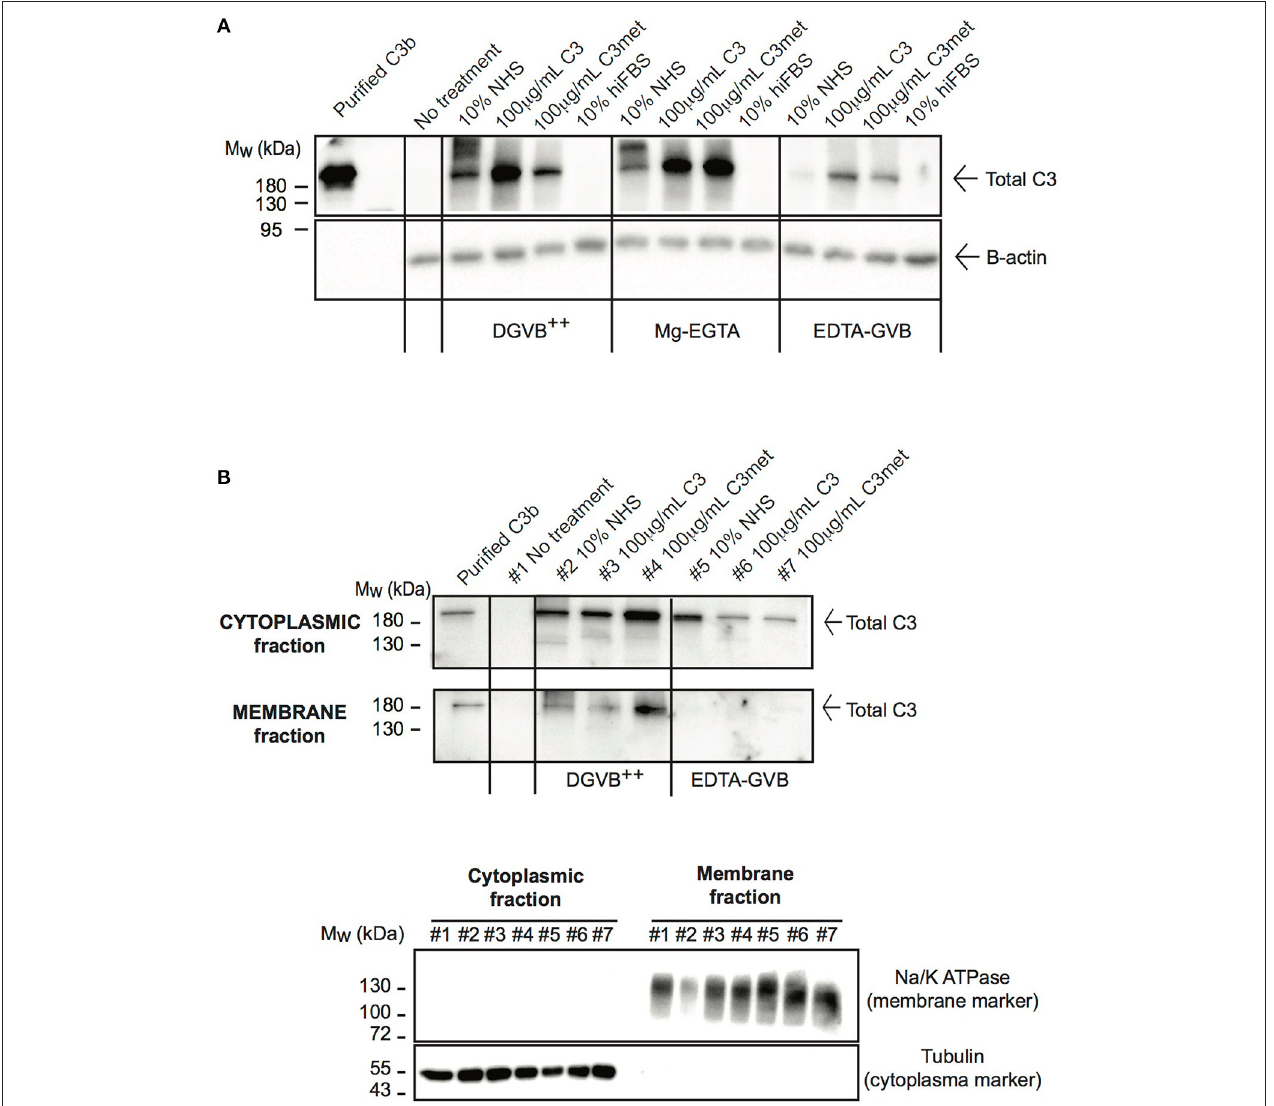
FIGURE 2 | C3 is internalized by human B cells. (A) Western blot results analyzing the uptake of C3 by Raji B cells. Cells were treated with distinct sources of C3 (10% NHS, 100 µ g/ml C3, 100 µ g/ml C3met, 10% hiFBS,) in DGVB ++ , Mg-EGTA, or EDTA-GVB buffer for 1h at 37 ◦ C. C3 uptake was investigated by Western blot using the goat polyclonal anti-C3 antibody (Quidel) under non reducing conditions. Data shown are representative of four independent experiments. (B) Western blot results confirming the presence of internalized C3 in the cytoplasm. Cells were incubated with distinct sources of C3 (20% NHS, 200 µ g/ml C3, 200 µ g/ml C3met) in DGVB ++ or EDTA-GVB buffer for 1h at 37 ◦ C. After lysis, cytoplasmic and membrane fractions were separated and analyzed by Western blot with the goat polyclonal anti-C3 antibody (Quidel) under non reducing conditions. The purity of distinct cellular fractions was verified using antibodies against B-tubulin (cytoplasmic marker) and Na/K ATPase (membrane marker) under reducing conditions. Results shown are representative of two independent